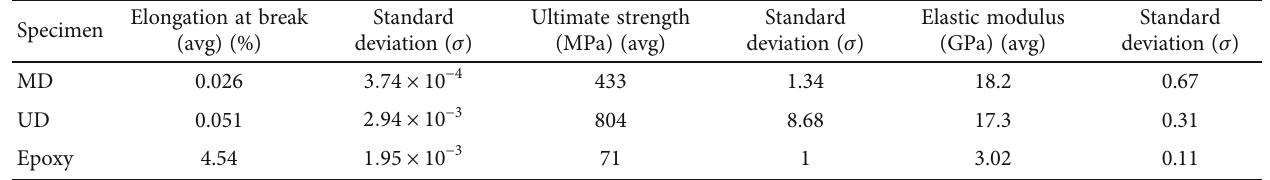
Table 3: Mechanical properties of the UD and the MD composites and the epoxy specimens.